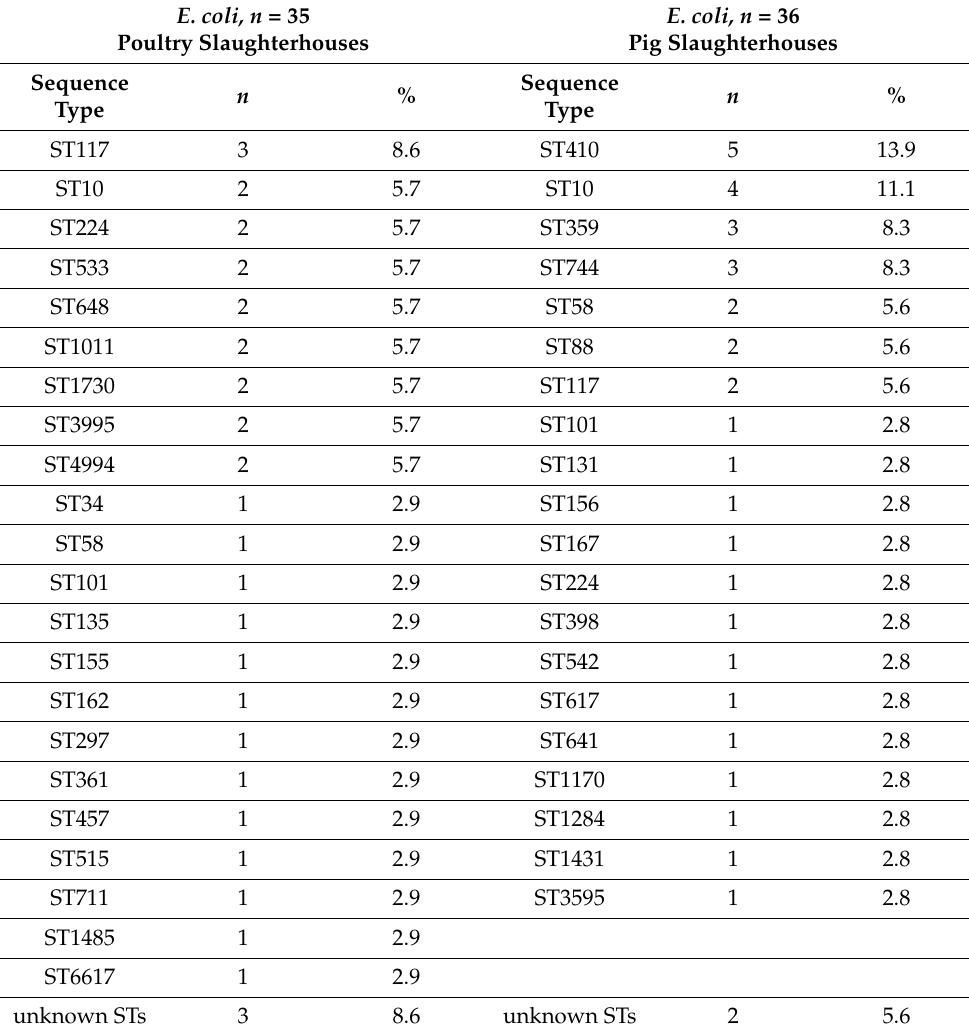
Table 2. Multi-locus sequence types (MLST) distribution of selected E. coli isolates recovered from poultry and pig